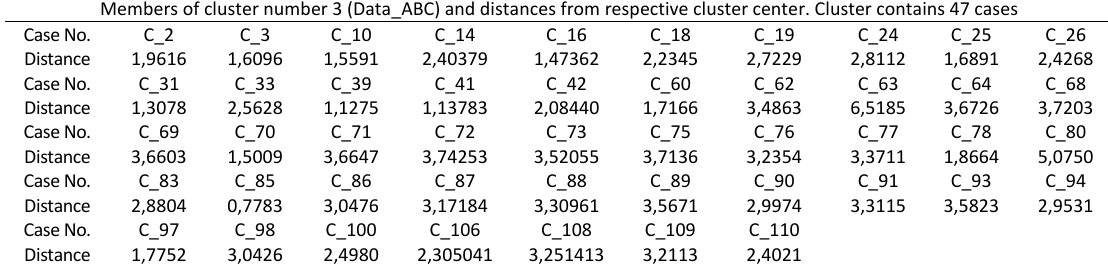
Table 5: The structure of Category C offices group B4 of the KNUTD academic building (STATISTICA 10 listing) Members of cluster number 3 (Data_АВС) and distances from respective cluster center. Cluster contains 47 cases Case No.